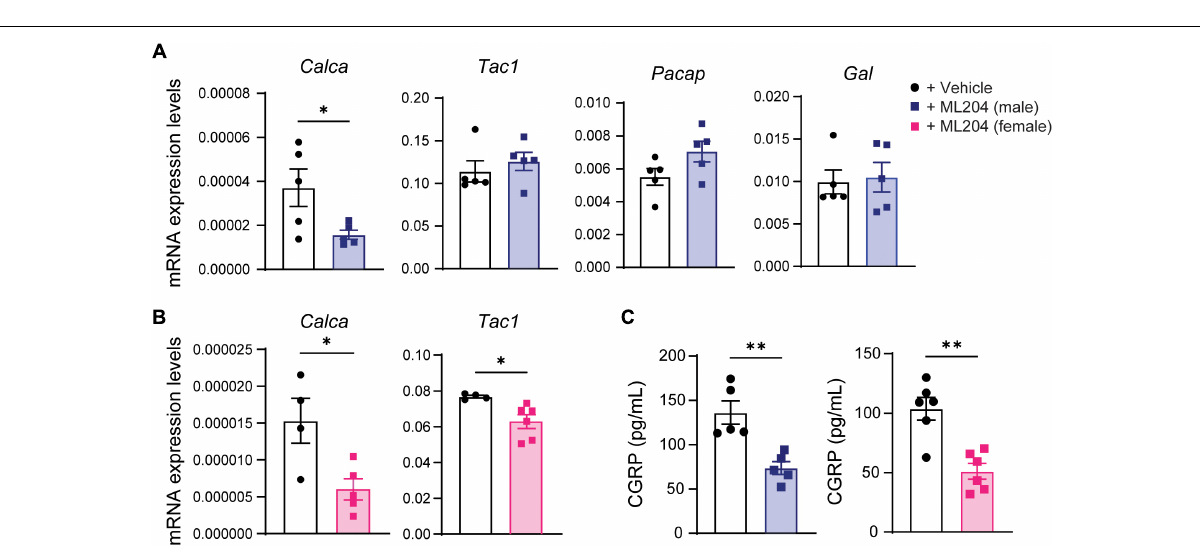
FIGURE 4 | TRPC4 inhibitor ML204 decreases CGRP transcriptional and protein levels in the chronic migraine mouse model (A,B) Transcriptional analyses of various neuropeptides in DRG tissues from male (A) and female (B) mice treated with ML204 or vehicle control (PBS) after 9 days in the NTG-evoked chronic pain